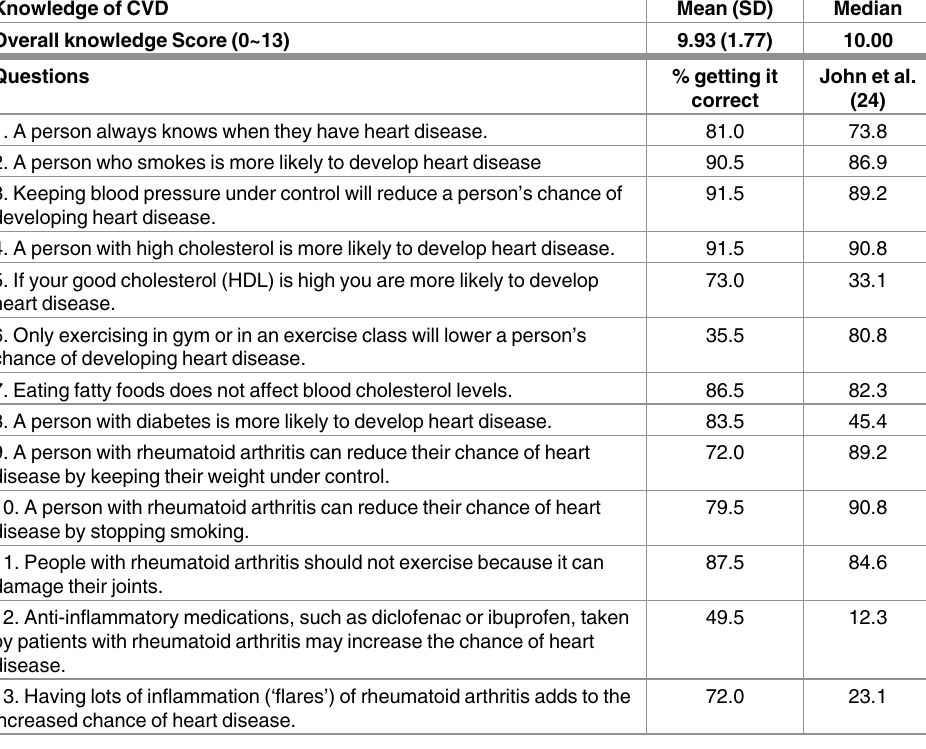
Table 2. Knowledge of CVD in patients with RA free of CVD ( n =